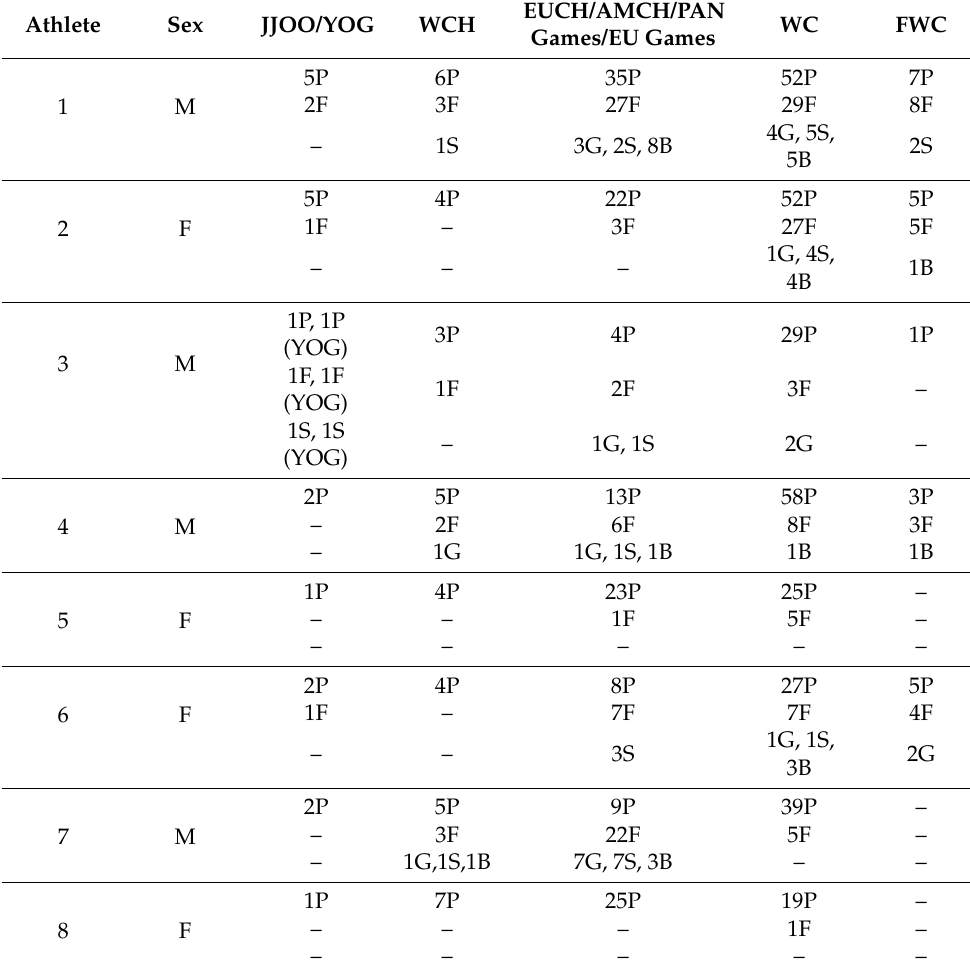
Table 1. Participants profiles, number of participations in first level international competitions, times finalist and